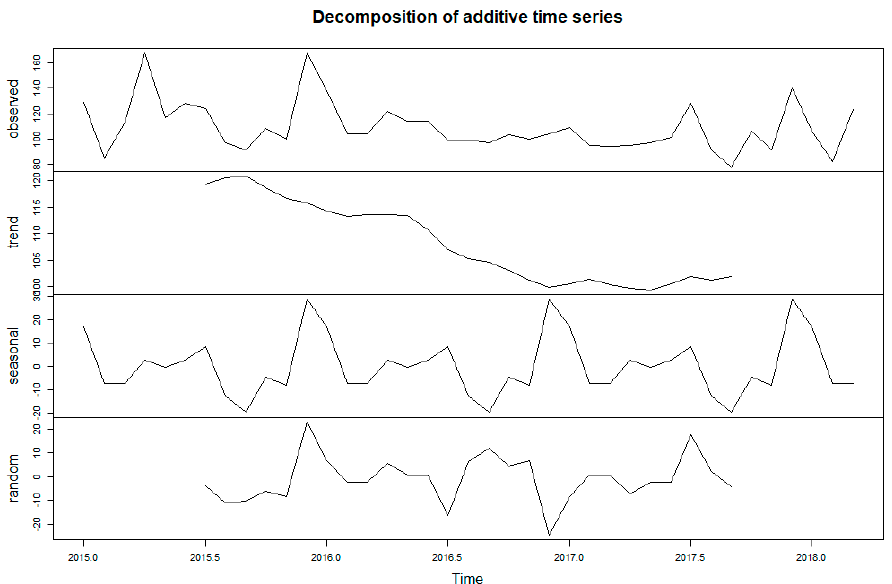
Figure A2. Decomposition of time series trends in monthly homicide reports. Panel observed shows observed time series data. Panel “trend” shows general trend of decreasing monthly homicides between January 2015 and March 2018 (monthly homicides = − 16.07ln(x) + 154.84; R² = 0.9119). Panel “seasonal” shows a seasonal trend with marked peaks near the beginning of the year and a smaller peak at mid-year. Panel “random” shows the unexplained variation.